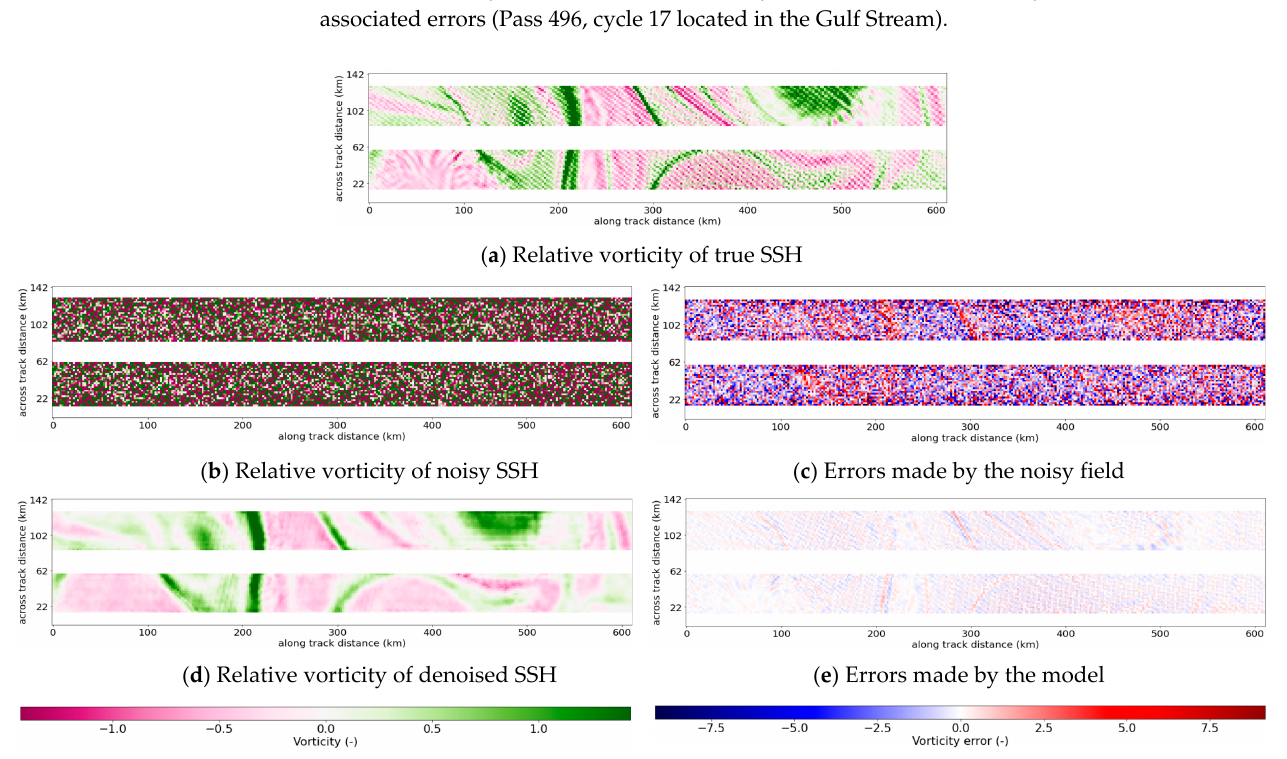
Figure 5. Relative vorticity of ( a ) True SSH, ( b ) Noisy SSH, ( d ) SSH denoised by the U-Net and ( c , e ) their associated errors (Pass 496, cycle 17 located in the Gulf Stream).